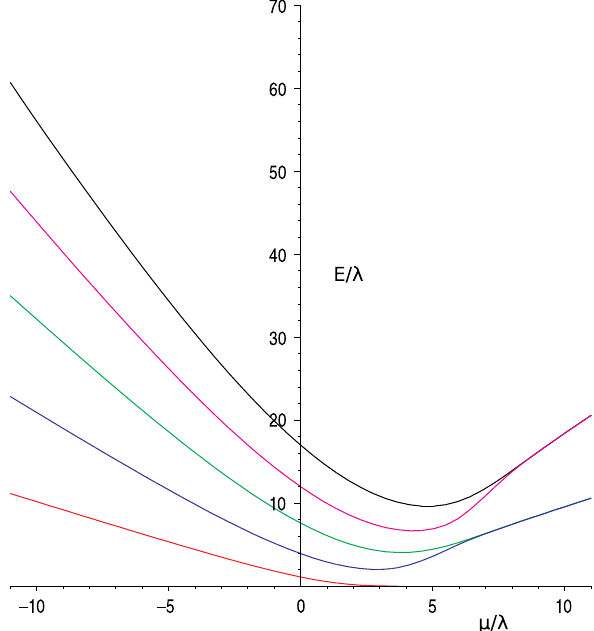
Fig. 2 Plot of the universal ratio E /λ for the first five eigenvalues as functions of μ/λ from − 11 to + 11